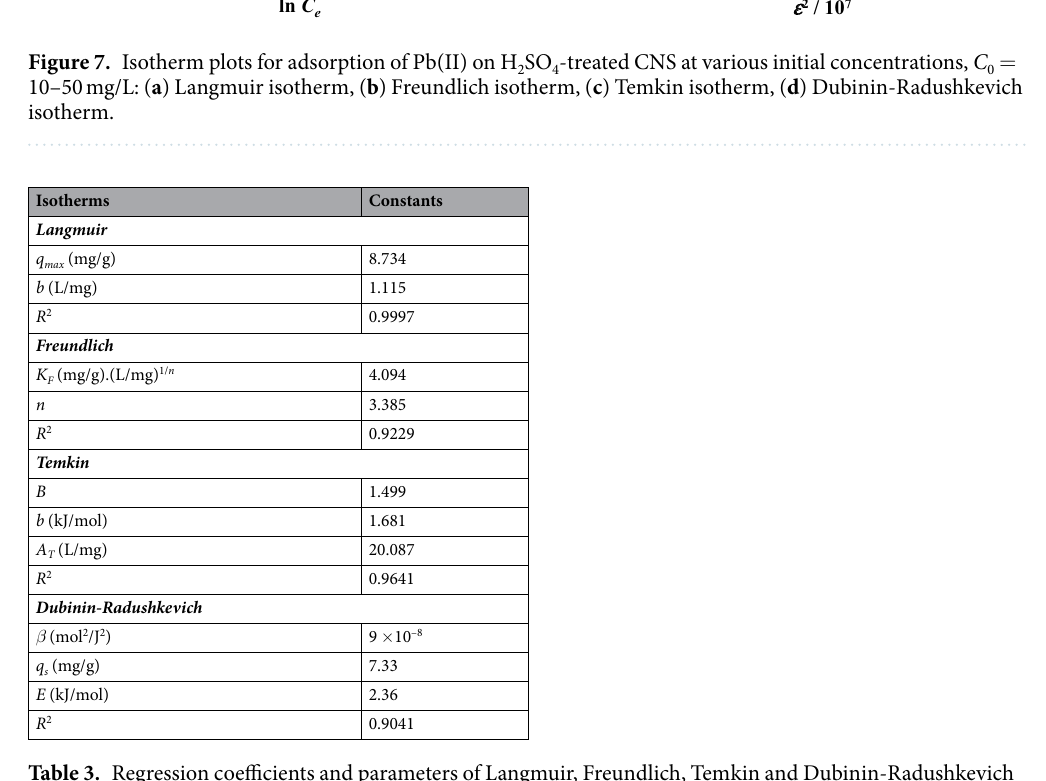
Table 3. Regression coefficients and parameters of Langmuir, Freundlich, Temkin and Dubinin-Radushkevich